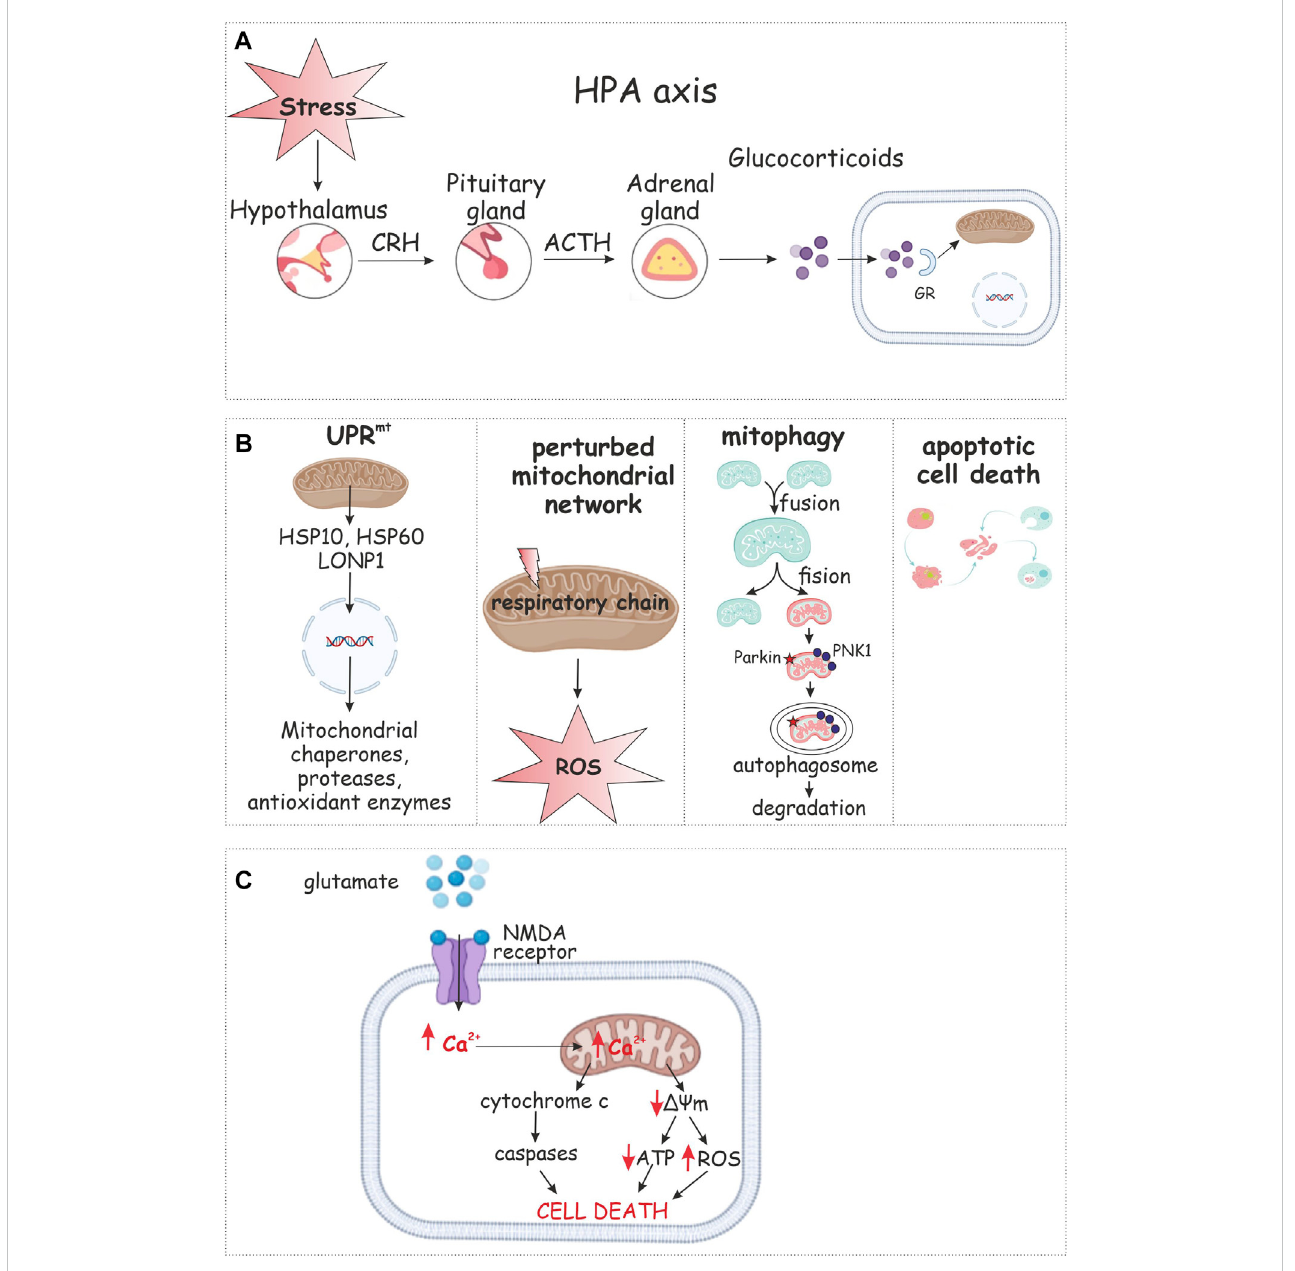
FIGURE 2 Mitochondrial response to PTSD. The hypothalamic – pituitary – adrenal (HPA) axis is the primary neuroendocrine pathway involved in stress response via release of secretions (A) . Glucocorticoids appear to regulate mitochondrial transcription. Mitochondrial stress response includes changes in mitochondrial dynamics, retrograde signaling, the mitochondrial unfolded protein response (UPR mt ), selective autophagy of mitochondria (mitophagy), or apoptotic cell death (B) . Stress results in synaptic release of glutamate and binding to NMDA receptor that leads to calcium in fl ux. Ca 2+ overload results in collapse of mitochondrial membrane potential ( ΔΨ m), decrease in ATP production, and enhanced ROS generation (C)